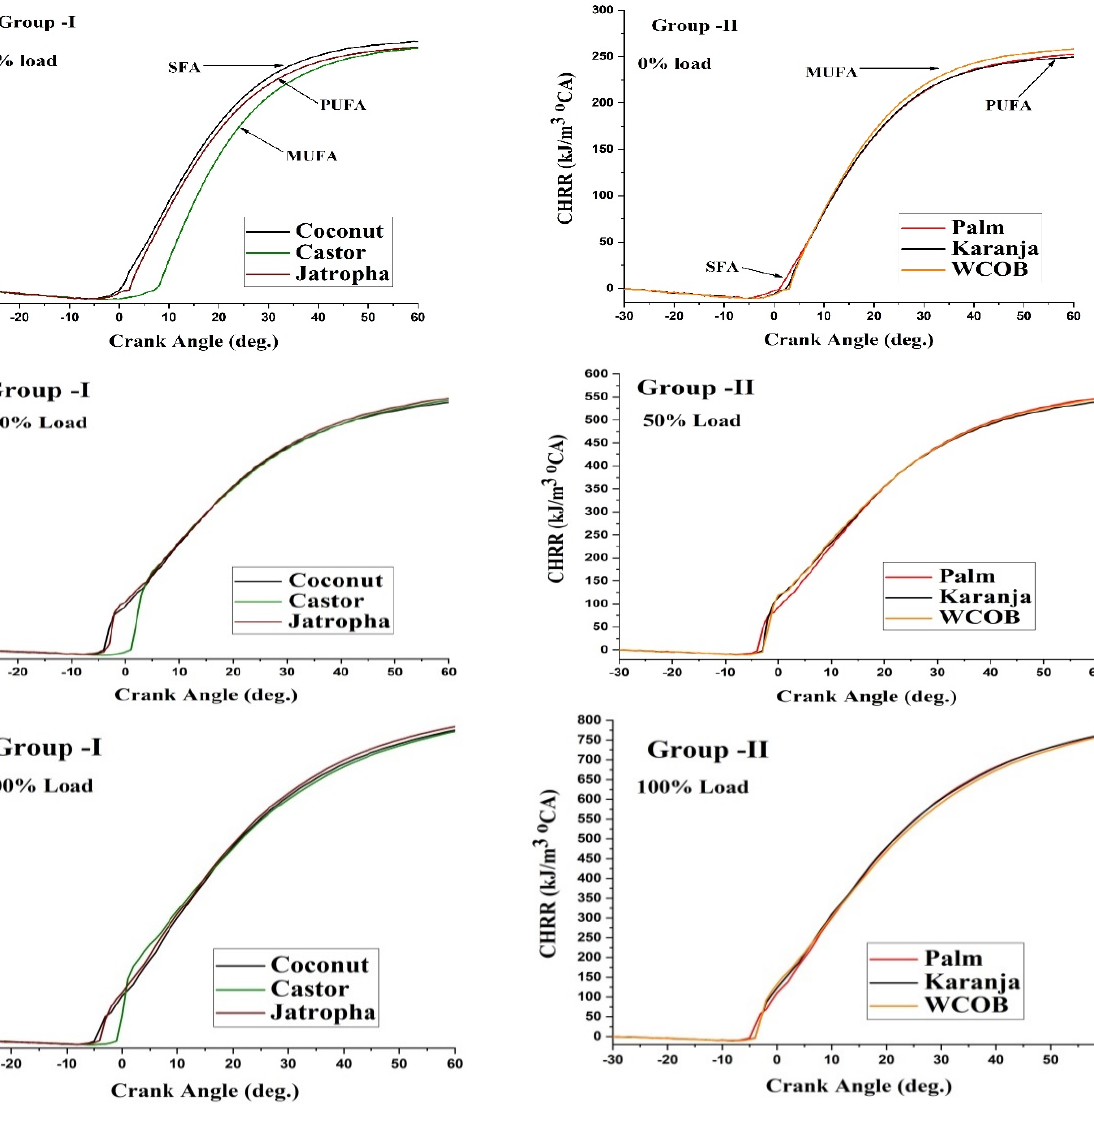
Figure 9. Cumulative heat release at 0%, 50%, and 100% load.